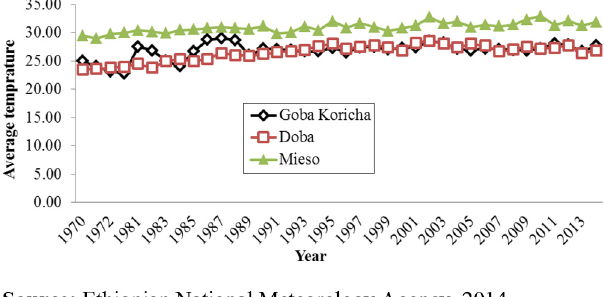
Figure 2. Average crop season temperature in the three